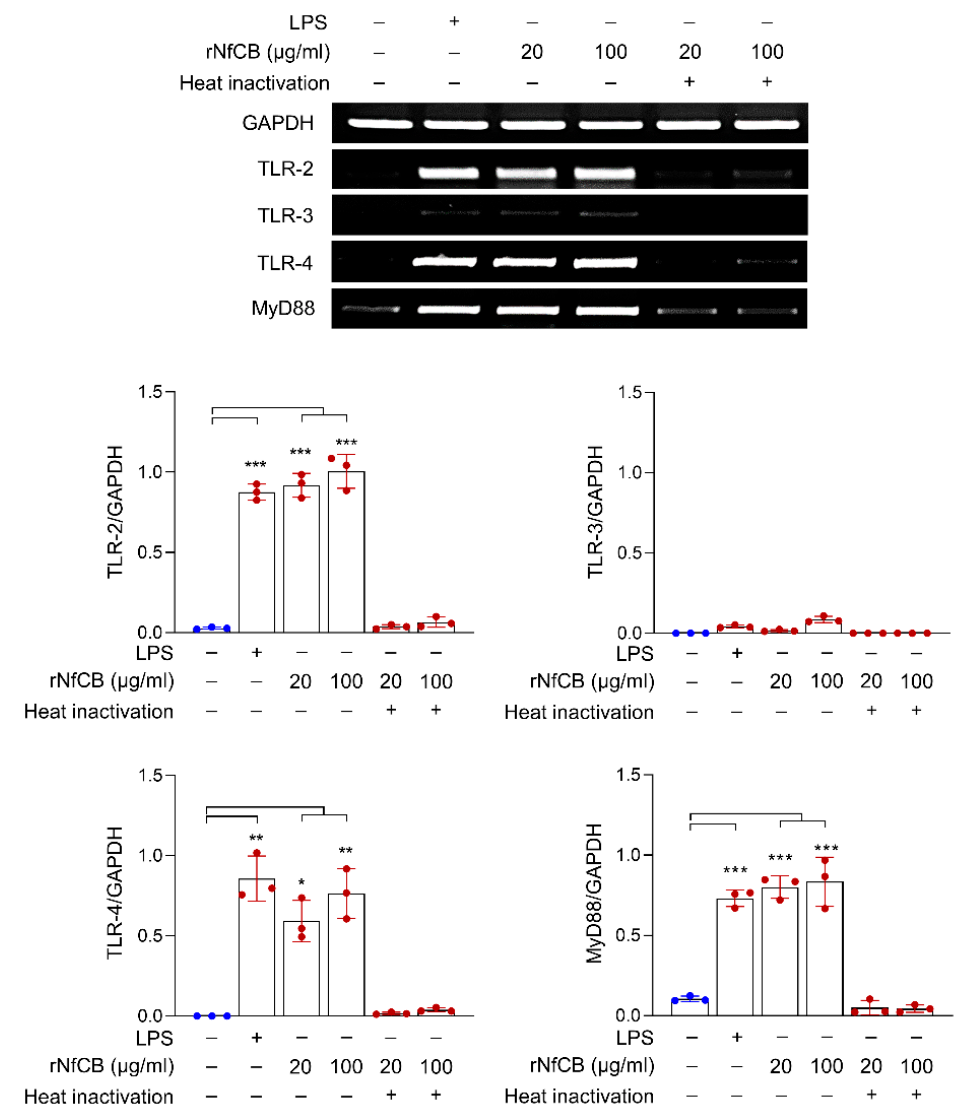
Figure 1. rNfCB activates BV-2 microglial cells via the MyD88-dependent TLR-2/TLR-4 pathway. BV-2 microglial cells were treated with different concentrations (20 µg/mL or 100 µg/mL) of active or heat-inactivated rNfCB. Cells were harvested at 6 h after treatment. Expression levels of TLR-2, TLR-3, and TLR-4, and the downstream adaptor MyD88 were analyzed via semi-quantitative RT-PCR. Bar graphs show the quantitative expression pattern of each gene, analyzed as the fold induction of each gene relative to GAPDH inthree independent experiments. One-way ANOVA with Dunnett’s post hoc test was performed as multiple comparisons with the negative control without treatment with either LPS or rNfCB. *** p < 0.0001, ** p < 0.001, * p < 0.01. 3.3. rNfCB Induces the Enhanced Production of Pro-Inflammatory Cytokines in BV-2 Microglial Cells The expression profiles of cytokines and chemokines in BV-2 microglial cells stimulated by rNfCB were analyzed (Figure 2). BV-2 microglial cells stimulated with rNfCB produced diverse pro-inflammatory cytokines and chemokines, particularly TNF- α , IL-6, interferon gamma (IFN- γ ), macrophage colony-stimulating factor (M-CSF), macrophage inflammatory protein 2 (MIP-2), and IFN- γ -inducible protein 10 (IP-10). The expressions of IL-1 α and IL-1 β were also detected. Meanwhile, no or low level of anti- inflammatory cytokines such as IL-4, IL-10, and IL-13 was found. Expression profiles of major pro-inflammatory cytokines were further investigated. Expression levels of pro-